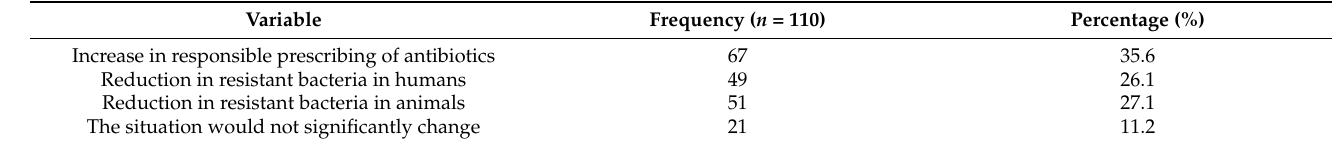
Table 3. The veterinarians’ opinion on the potential effect of AMS guidelines on specified